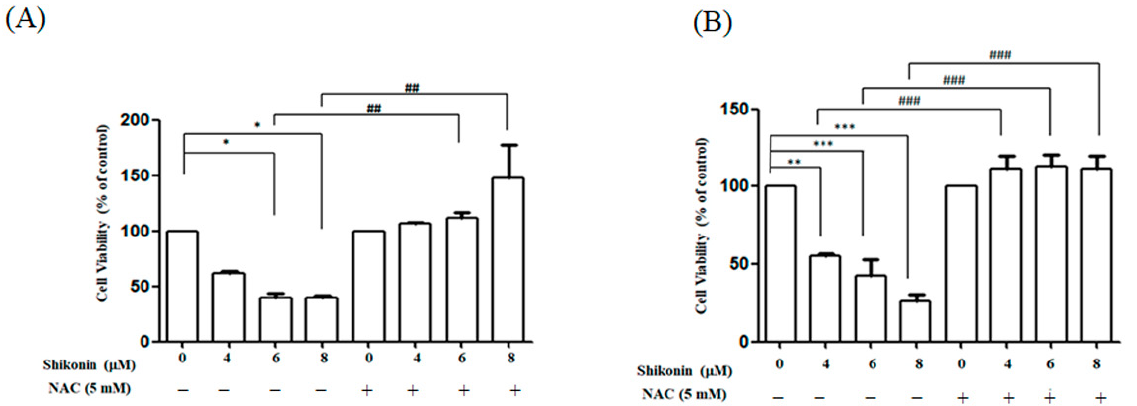
Figure 1. Shikonin dose-dependent mitigated cell viability in renal cancer cell (RCC) cells, and N-acetyl cysteine (NAC) reversed the phenomenon. 3-(4,5-Dimethylthiazol-2-yl)-2,5-diphenyltetrazolium bromide (MTT) assays of ( A ) ACHN and ( B ) Caki-1 cells treated with shikonin for 24 h with or without pretreatment with 5 mM NAC. Data represent means ± standard deviation from at least three independent experiences. * p < 0.05, ** p < 0.01 and *** p < 0.001 compared with the control group. ## p < 0.01 and ### p < 0.001 compared with the NAC pretreated group.